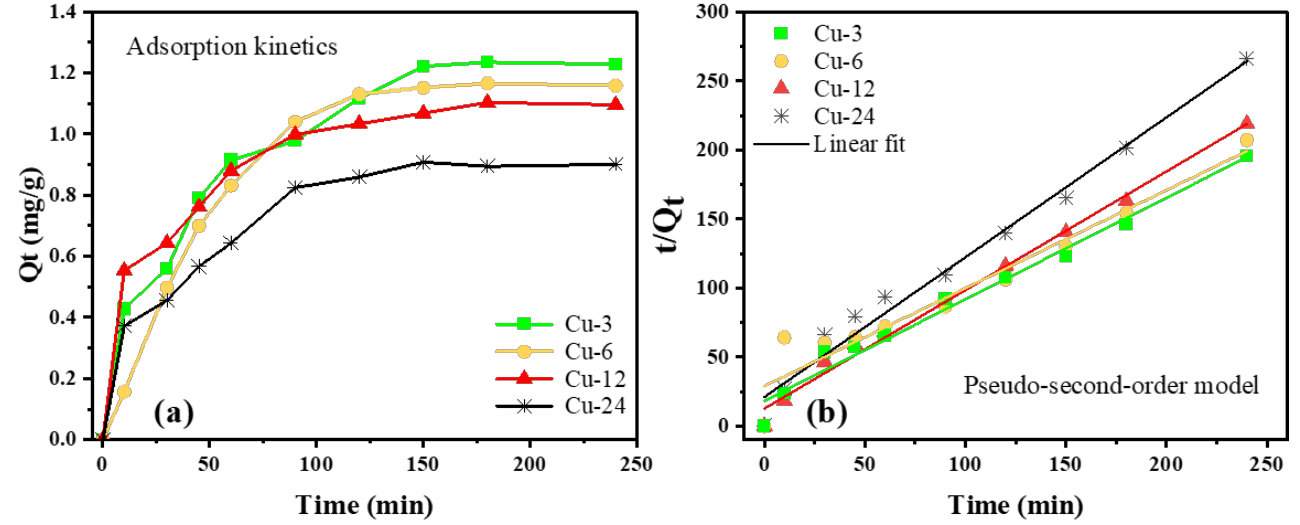
Figure 6. Adsorption kinetics ( a ) and the pseudo-second-order kinetic ( b ) plots for 5 mg of the nanocomposite in 15 mL aqueous solution containing a 5 mg/L concentration of MB.